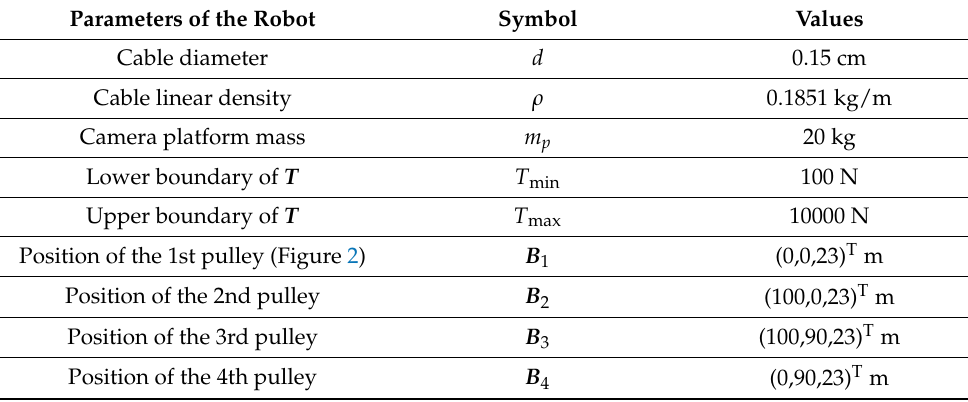
Table 1. Parameters of the camera